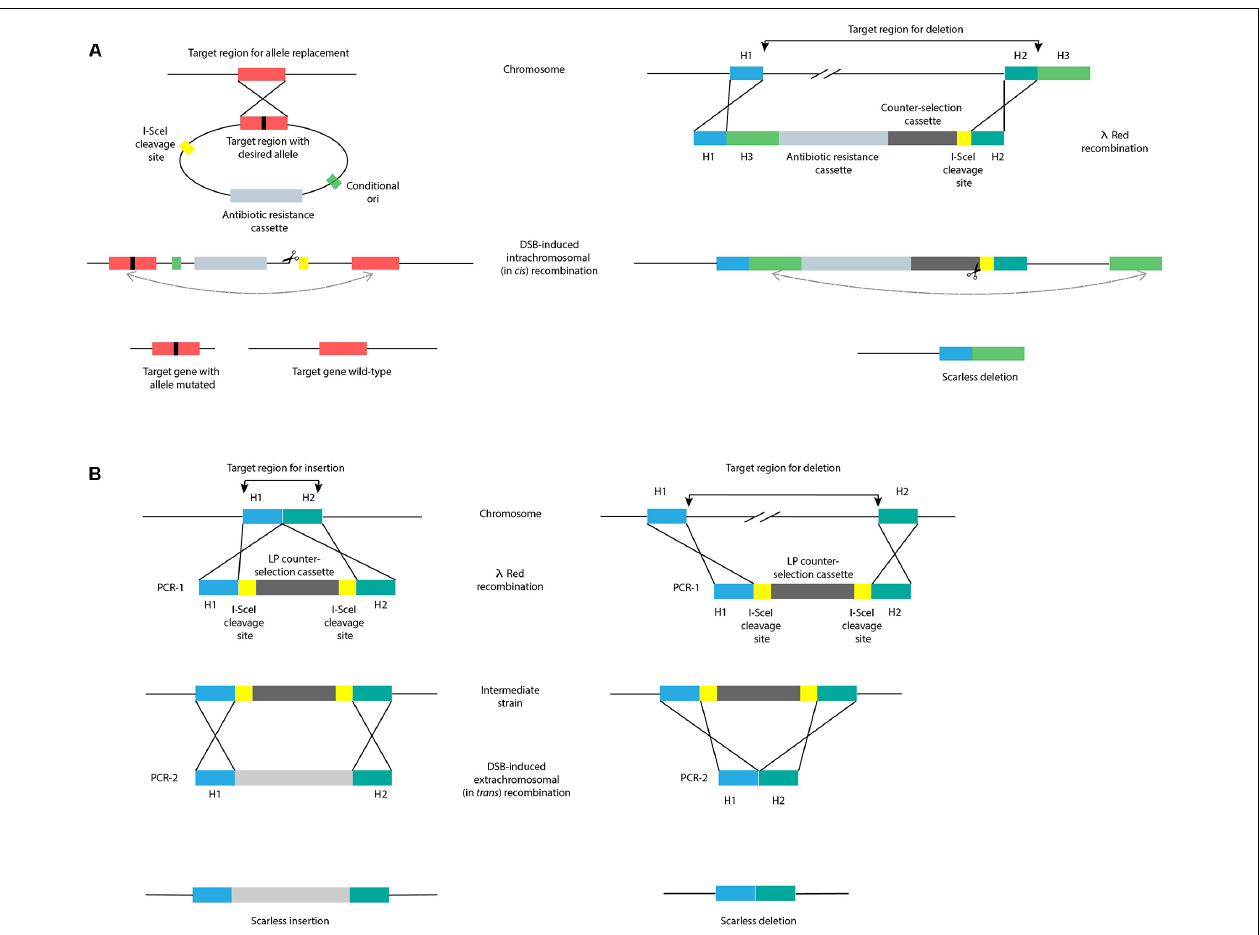
FIGURE 4 | Scarless genome editing by intra- ( in cis ) or extrachromosomal ( in trans ) recombination. (A) DSB-induced in cis recombination by I-SceI endonuclease, with a mutated version of the target region inserted into the chromosome by a conditional replicating suicide plasmid (left) or with an identical sequence inserted into the chromosome by λ red recombination with a linear dsDNA fragment (right). (B) DSB-induced in trans recombination by I-SceI endonuclease, comprising the initial generation of an intermediate strain by introduction of landing pad (LP) counter-selection cassette (PCR-1) by λ red recombination. Subsequent introduction of editing substrates (PCR-2) into the intermediate strain and expression of I-SceI endonuclease stimulates excision of the LP and repair of the DSB by recombination with editing substrates, overall resulting in transformants with an insertion (left) and a deletion (right). H1-H3, homology regions 1-3; DSB, double strand break; LP, landing